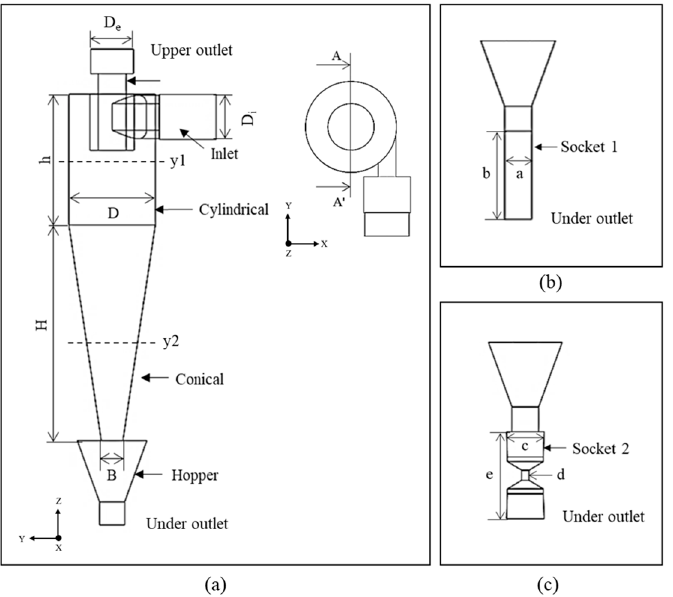
Figure 2. Schematic diagram of cyclone models; ( a ) Model 1 (basic), ( b ) Model 2 (added socket 1), and ( c ) Model 3 (added socket 2). Table 1. Dimensions of the cyclone